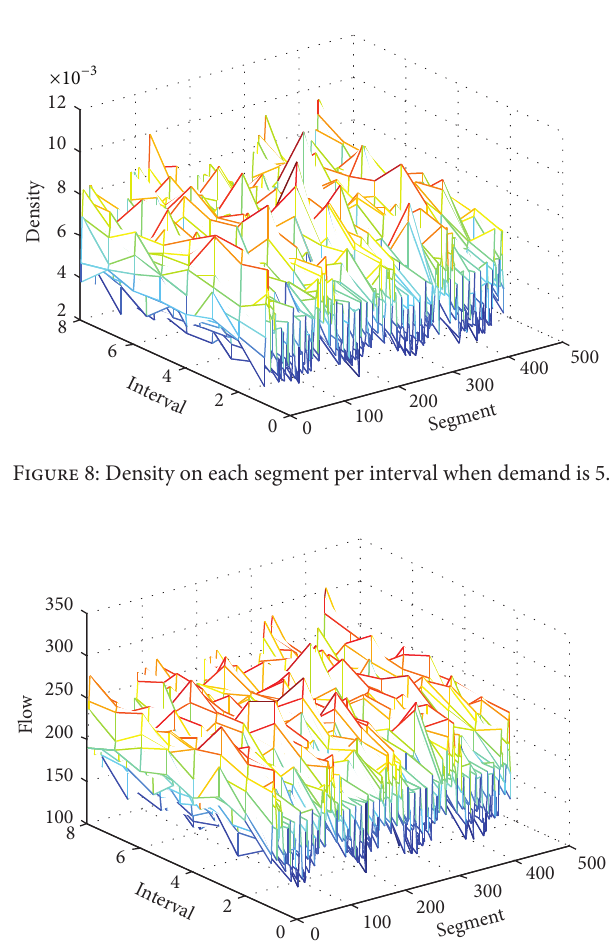
Figure 9: Flow on each segment per interval when demand is 5.